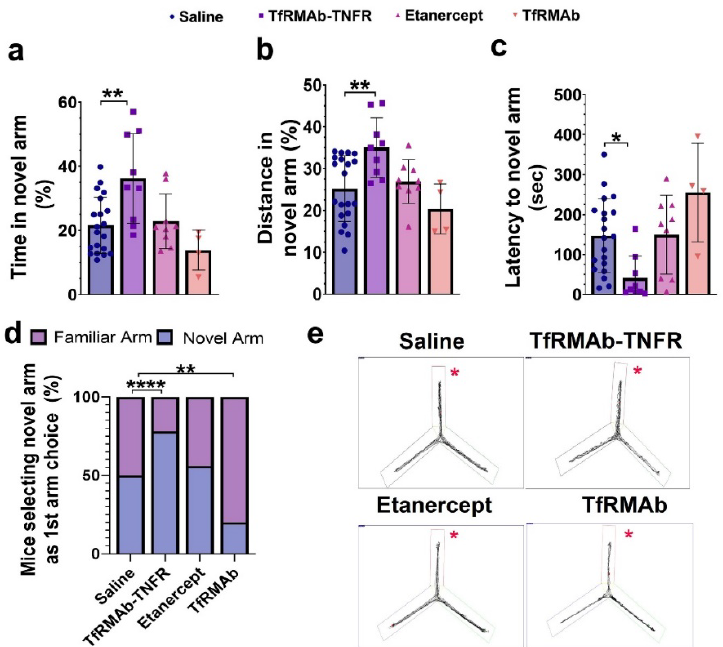
Figure 3. Effect of chronic TfRMAb-TNFR dosing on spatial reference memory using the Y-maze test. TfRMAb-TNFR treatment increased the time spent ( a ) and distance traveled ( b ) in the novel arm and reduced the latency to the novel arm ( c ) compared to the saline-treated mice. More TfRMAb-TNFR-treated mice selected the novel arm as their first choice compared to the saline-treated mice ( d ). Representative trajectory maps of mice in the Y-maze ( e ). The novel arm is shown by the red asterisk. Data are presented as mean ± SD of n = 4–20 per treatment group, numerical data were analyzed using the one-way ANOVA with the Holm Sidak’s post hoc test, and nominal data were analyzed using the Fisher’s exact test. * p < 0.05, ** p < 0.01, **** p < 0.0001 for the indicated comparisons.